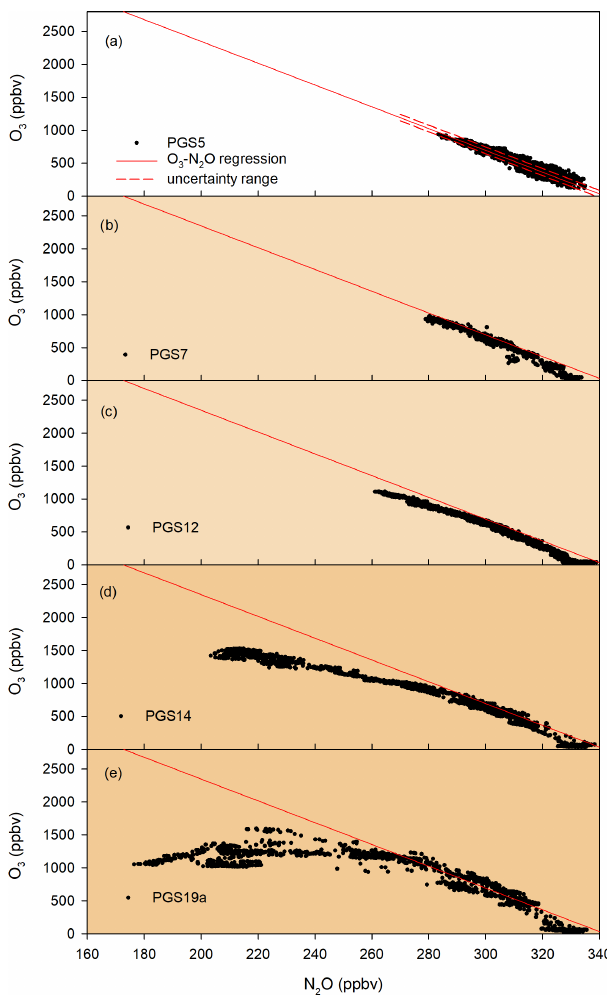
Figure 11. POLSTRACC flight on 20 January 2016. During this flight, particulate nitrate was observed. (a) Gas-phase NO y , (b) total nitrate (including particulate nitrate) and gas-phase nitrate, (c) same as (b) but with a smaller time interval, and (d) ratio of particulate nitrate (corrected for enhancement) to gas-phase